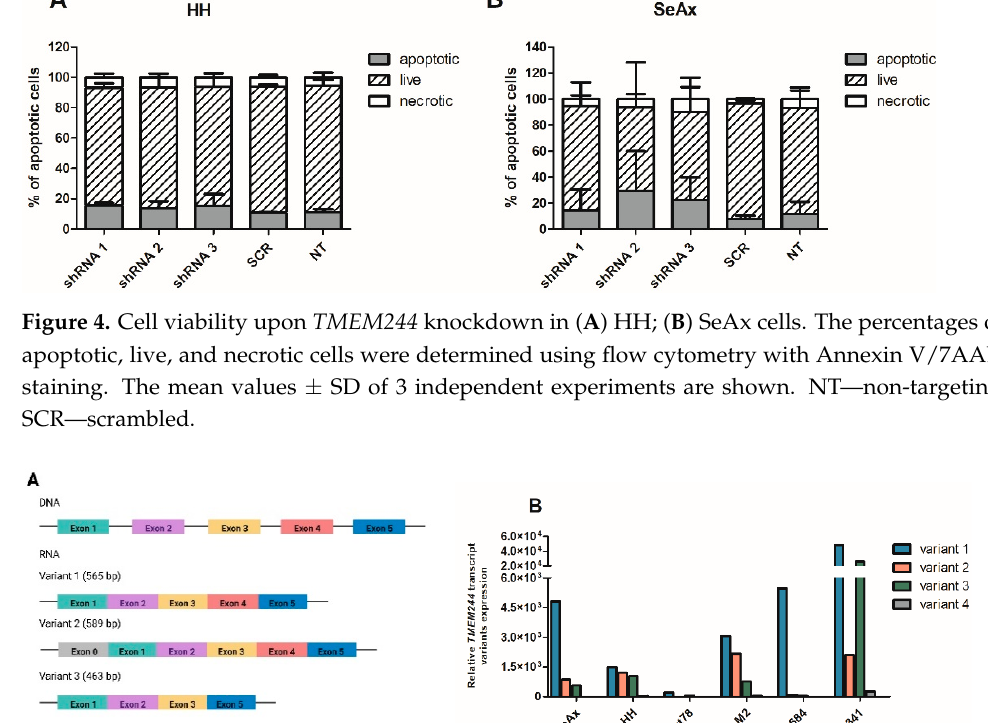
scheme; ( B ) relative expression of TMEM244 transcript variants analyzed by RT ‐ qPCR.